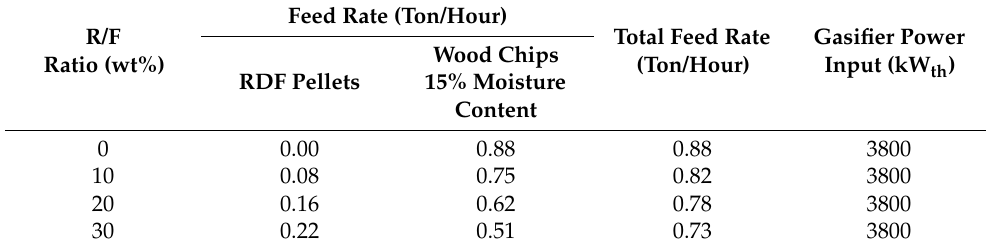
Table 3. Mass feed rate of wood chips and RDF pellets to the BFB gasifier bed.